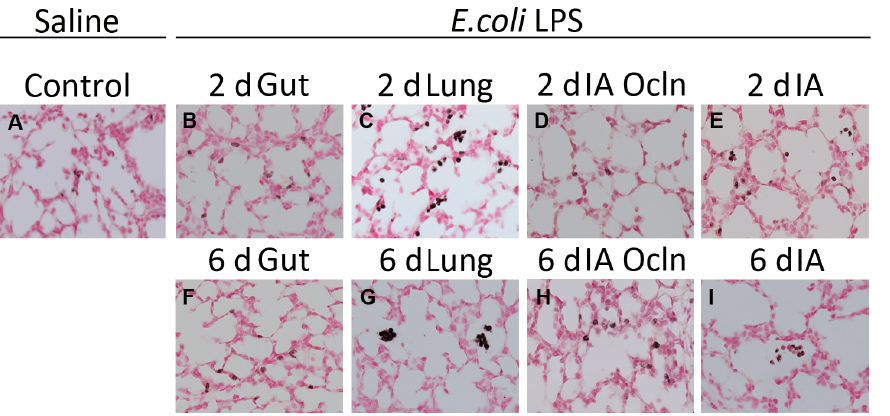
Figure 2. LPS infusion in the lung or the amniotic fluid induced myeloperoxidase (MPO) expression in the lung. Representative photomicrographs are shown for MPO immunostaining in saline control exposed lung (A), 2d (B) and 6d (F) ‘‘Gut’’, 2d (C) and 6d (G) ‘‘Lung’’, 2d (D) and 6d (H) ‘‘IA Ocln’’ and 2d (E) and 6d (I) ‘‘IA’’ groups. All images 20 6 magnification. The immunostained inflammatory cells (exhibiting dark brown staining) were increased in the 2d and 6d ‘‘Lung’’, 2d ‘‘IA’’ LPS and 2d ‘‘Gut’’ group, relative to controls (see quantitative counts of MPO positive cells in all the groups in Table 4).